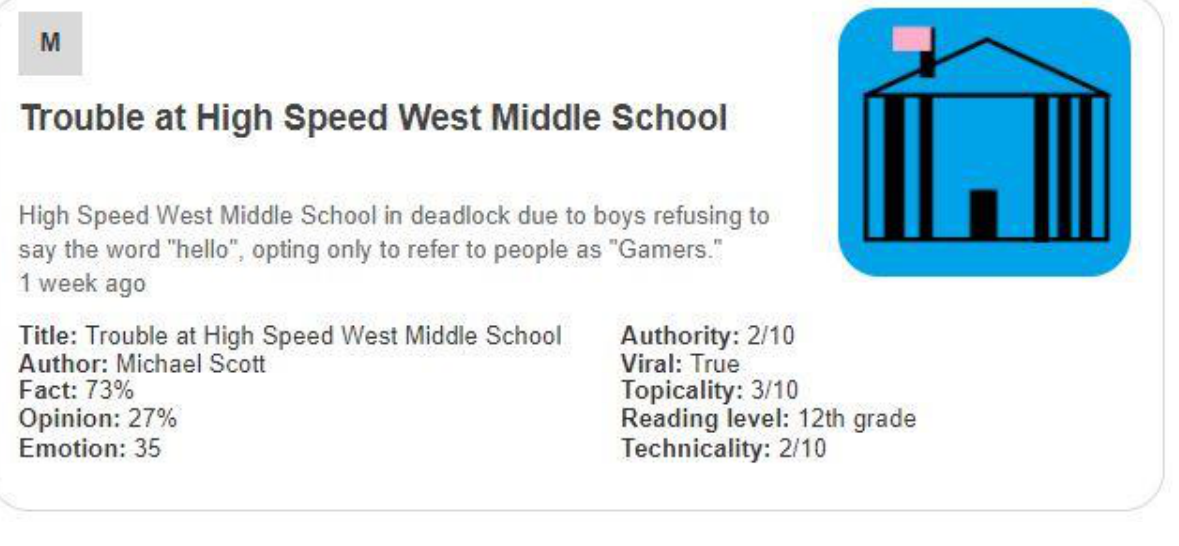
Figure 4. Informational Label 1 [16].